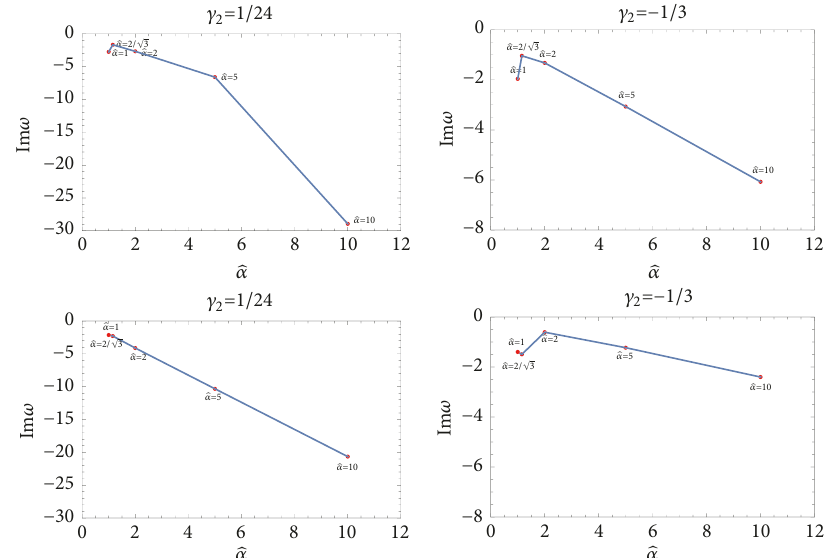
Figure 18: The dominate QNMs of the gauge modes (plots above) and the dual modes (plots below) for sample 𝛾 2 and ̂𝛼 .